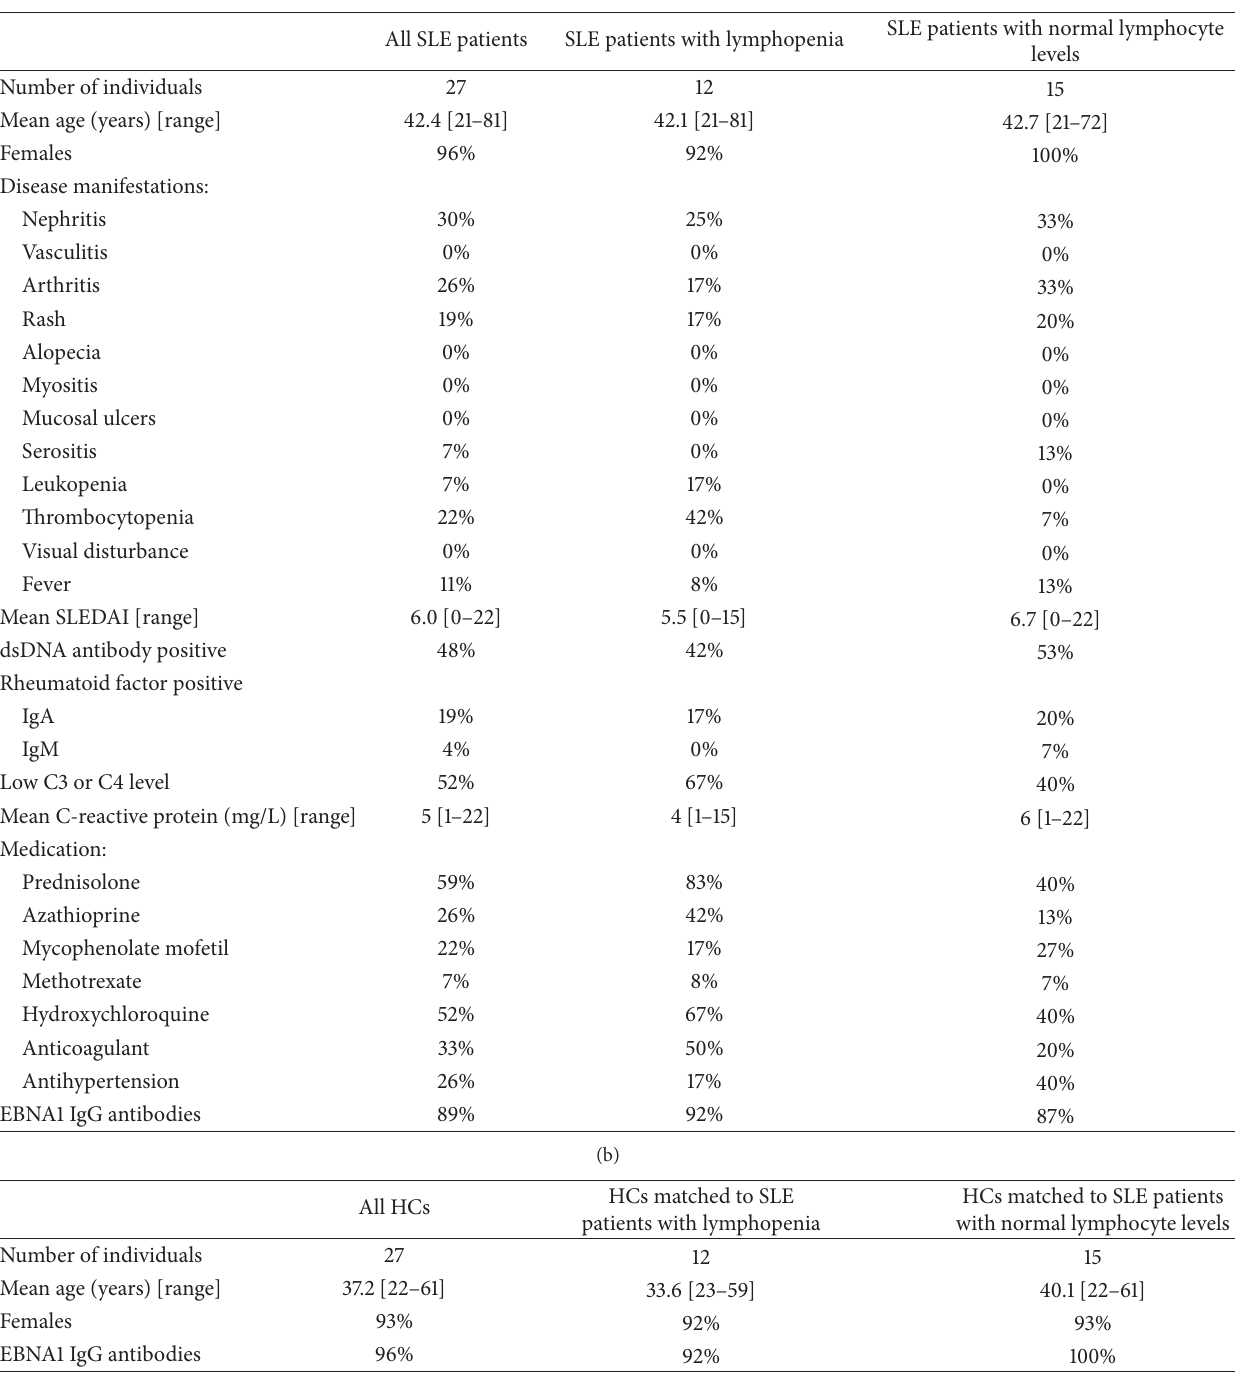
Table 2: (a) Clinical Characteristics of SLE patients and division into subgroups according to lymphocyte levels. (b) Characteristics of healthy